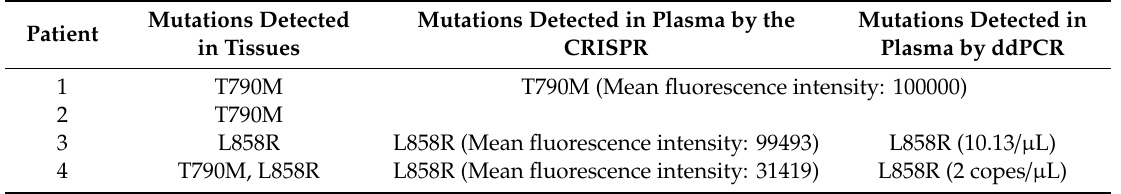
Table 5. Mutation status of the four lung cancer whose tissue biopsies were positive for T790M or L878R. Mutations Detected Mutations Detected in Plasma by the Mutations Detected in Patient in Tissues CRISPR Plasma by ddPCR 1 T790M T790M (Mean fluorescence intensity: 100000) 2 T790M 3 L858R L858R (Mean fluorescence intensity: 99493) L858R (10.13 / µ L) 4 T790M, L858R L858R (Mean fluorescence intensity: 31419) L858R (2 copes / µ